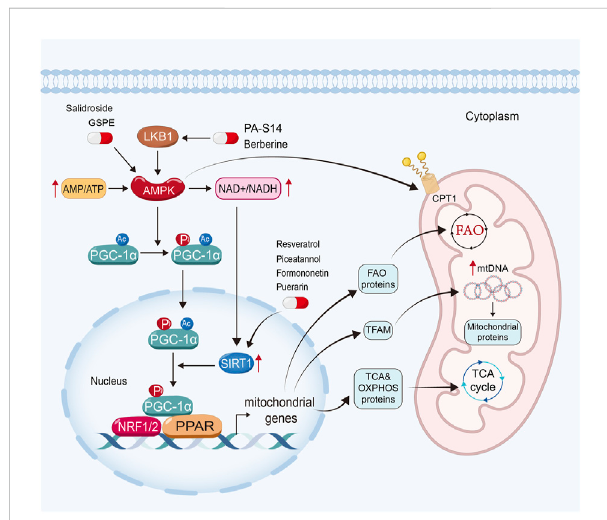
FIGURE 2 Enhancing mitochondrial biogenesis and energetics is a crucial therapeutic strategy for natural products to restore mitochondrial function in kidney diseases. PA-S14 and berberine promote mitochondrial biogenesis and energetics by activating LKB1, while salidroside and GSPE induce AMPK. Moreover, resveratrol, piceatannol, formononetin and puerarin exert their mitochondrial protective function via the activation of